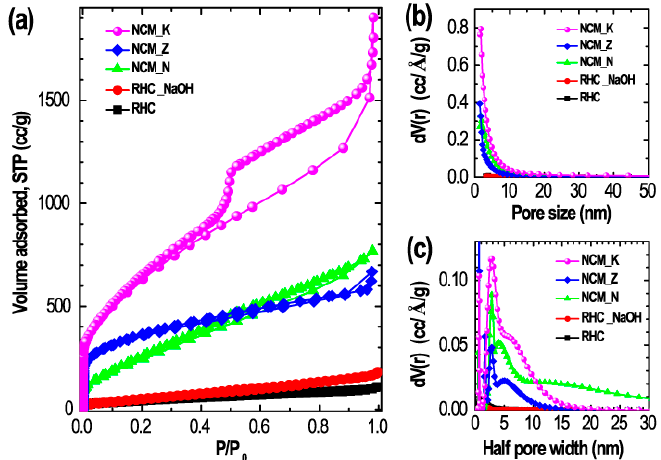
Figure 5. ( a ) Nitrogen adsorption-desorption isotherms of RHC, RHC_NaOH, NCM_N, NCM_Z, and NCM_K, ( b ) Corresponding pore size distribution curves as obtained from BJH method, and ( c ) Corresponding pore size distribution curves as obtained from DFT method.